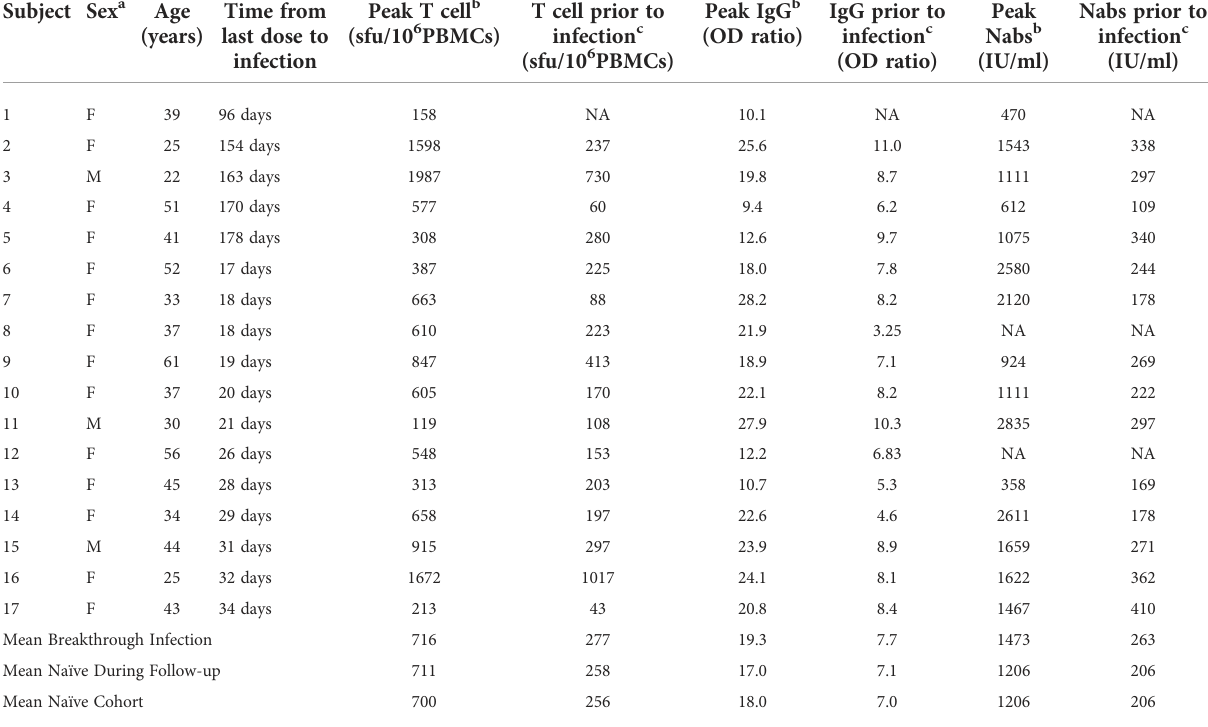
TABLE 1 Characteristics of SARS-CoV-2 infected individuals after mRNA